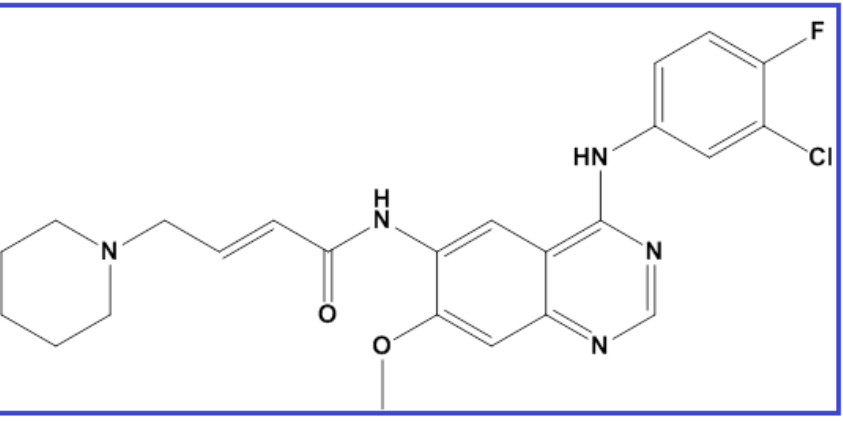
Figure 1. Chemical structure of dacomitinib (DCB).